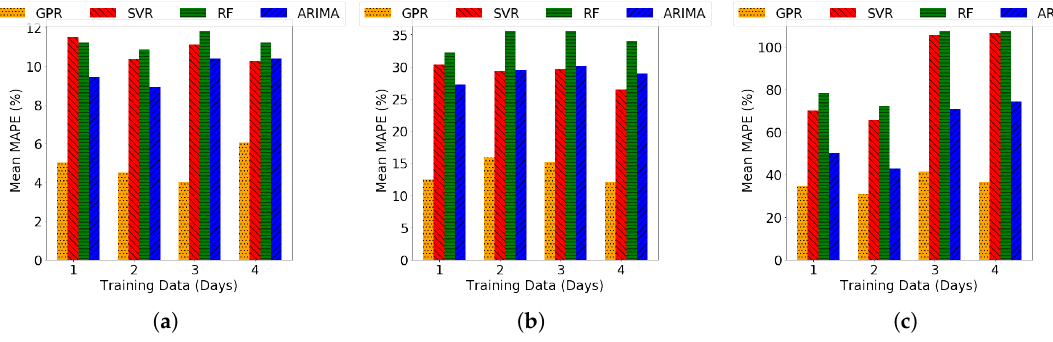
Figure 5. Mean of the MAPE of prediction over different weeks for varying duration of training data using GPR, SVR, RF and ARIMA. ( a ) CMU electric load; ( b ) Y2E2 cooling load; ( c ) Y2E2 lighting